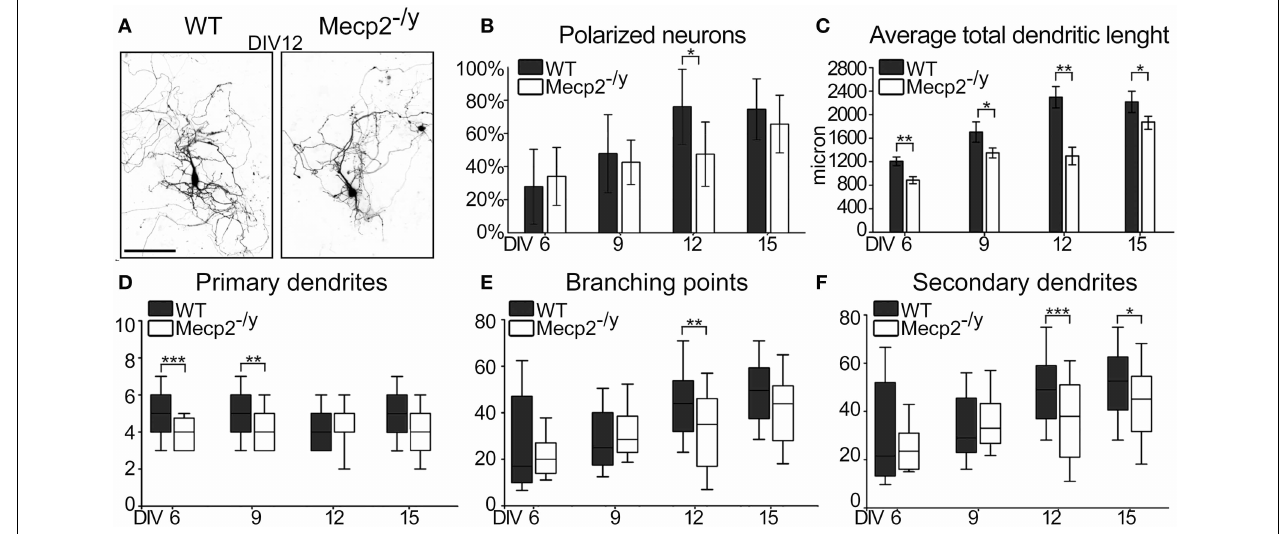
FIGURE 5 | Morphological characterization of WT and Mecp2 − / y mouse developing hippocampal neurons. (A) Representative images of both WT and Mecp2 − / y mouse hippocampal neurons at DIV12. (Scale Bar = 50 µ m) (B) Quantification of relative amount of polarized neurons in culture Data are expressed as mean ± SD , n = 4 cultures (C) Quantitative data of the average